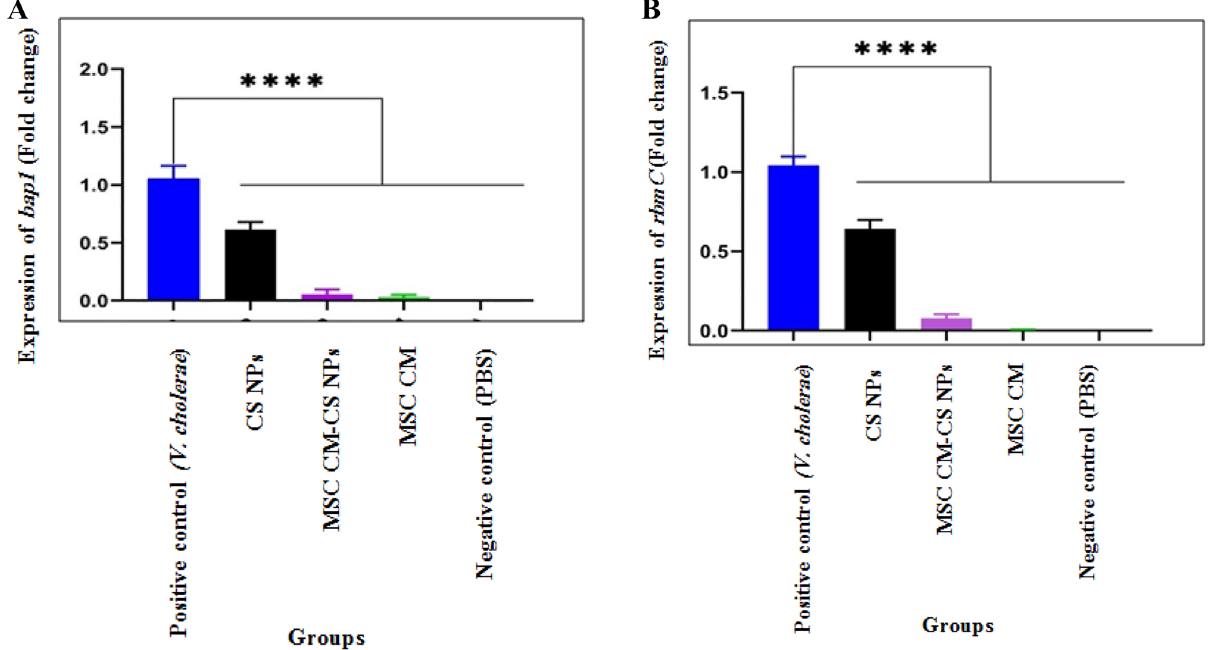
Figure 2. The inhibitory effect of three compounds MSC CM, MSC CM-CS NPs, and CS NPs on bap1 ( A ) and rbmC ( B ) gene expression in V. cholerae . PBS and V. cholerae without exposure to the compounds were used as negative and positive controls, respectively. Bars are presented as the mean of triplicate experiments. **** p < 0.0001 for V. cholerae vs. other